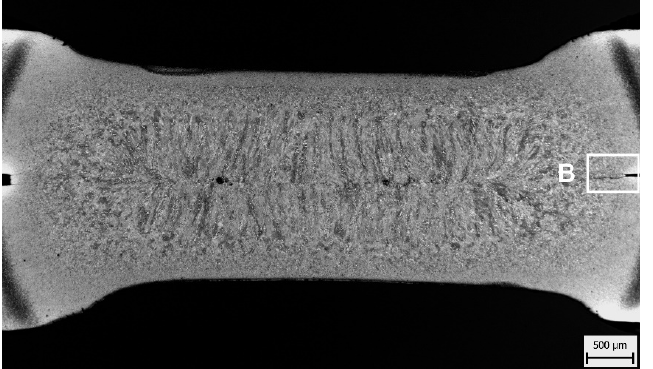
of the relevant heat-affected zones and detail of the pore at the original faying interface.